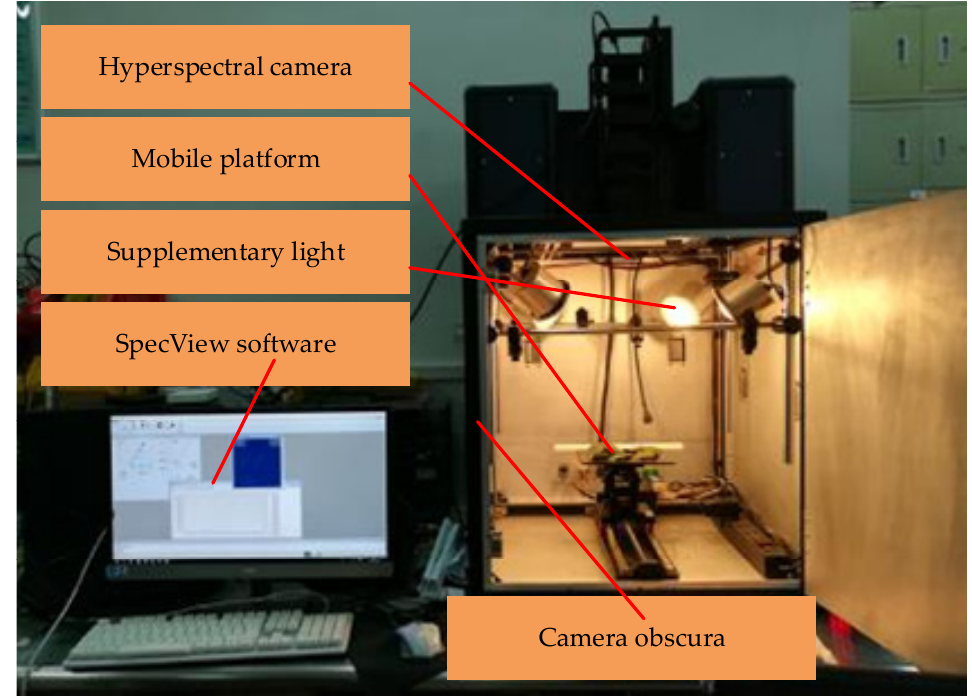
Figure 1. Agricultural robot system of hyperspectral imager.